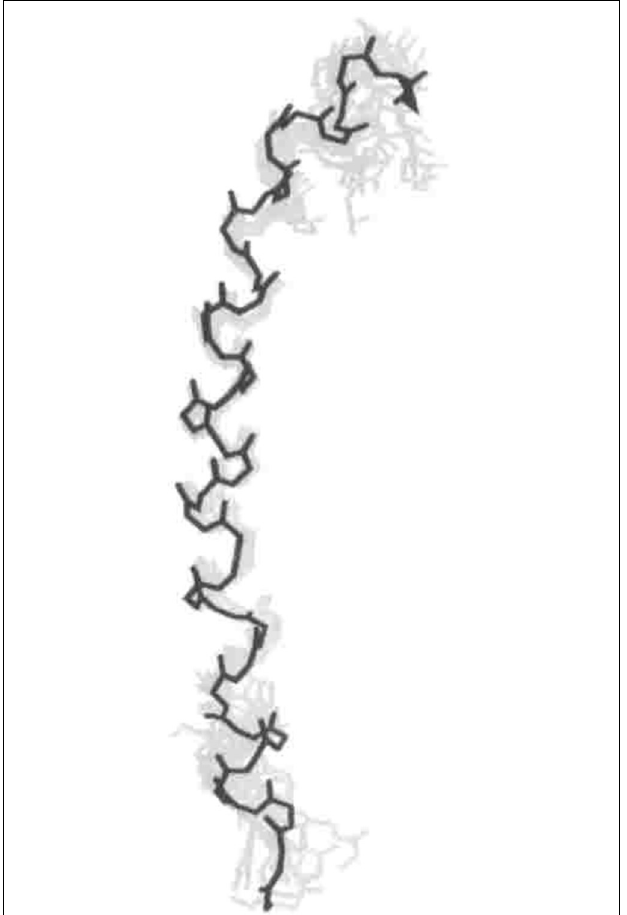
FIGURE 5 | NMR solution structure of one representative complete nebulin repeat (37 residues). The RMSD of this structure is 0.9Å. Reproduced with permission from Pfuhl et al.